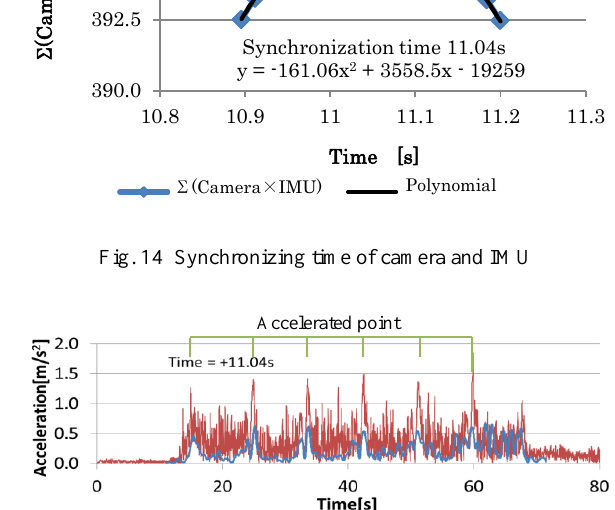
red points in this figure indicate the correlation of the camera and IMU before outliers are excluded by RANSAC. The red line indicates the linear regression obtained with the red points. The blue points are the points obtained by RANSAC. The blue line indicates the linear regression obtained using